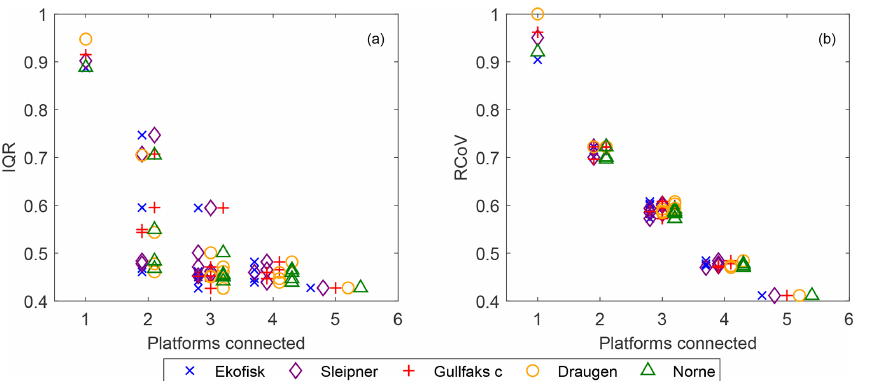
Figure 6. Panels (a) and (b) demonstrate how IQR (interquartile range) and RCoV (robust coefficient of variability) change as the array size of connected sites increases from one (single sites) to five (all sites connected), respectively.